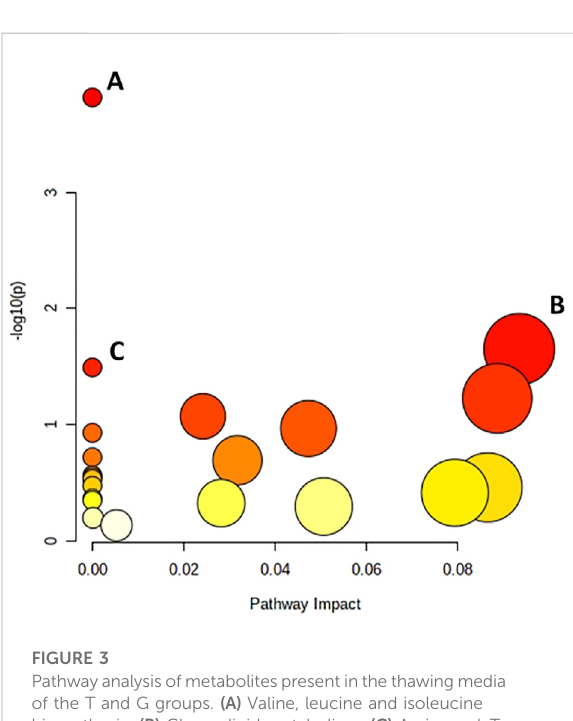
FIGURE 3 Pathwayanalysis ofmetabolitespresentinthethawingmedia of the T and G groups. (A) Valine, leucine and isoleucine biosynthesis; (B) Glycerolipid metabolism; (C) Aminoacyl-Trna